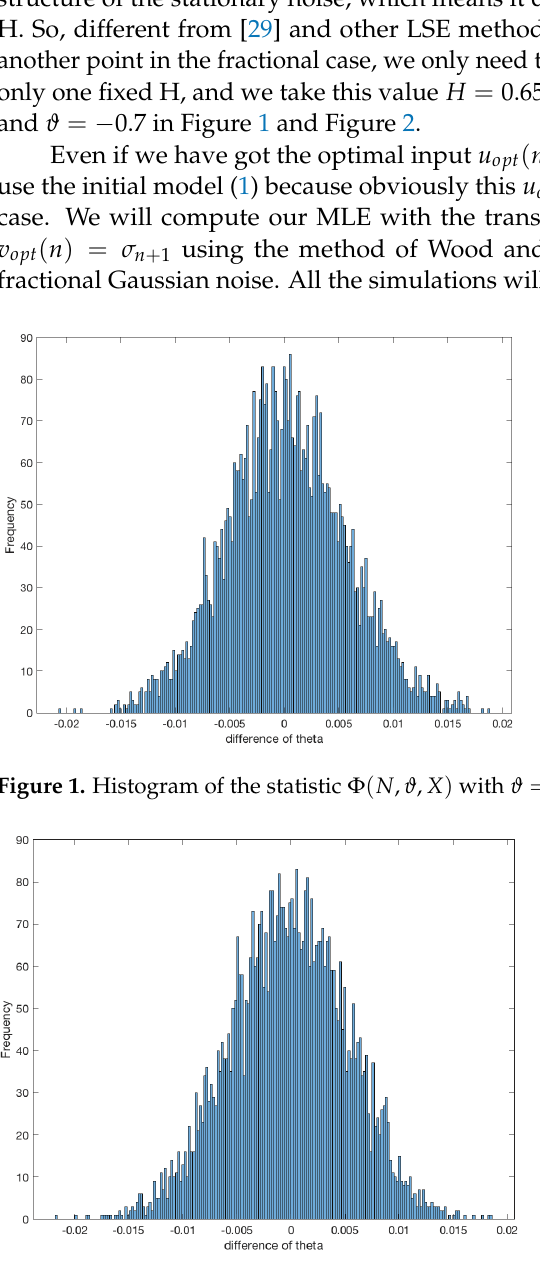
Figure 2. Histogram of the statistic Φ ( N , ϑ , X ) with ϑ = 0.7 and N =